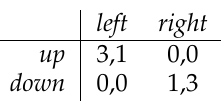
Figure 8. Material payoffs of a game with nonlinear